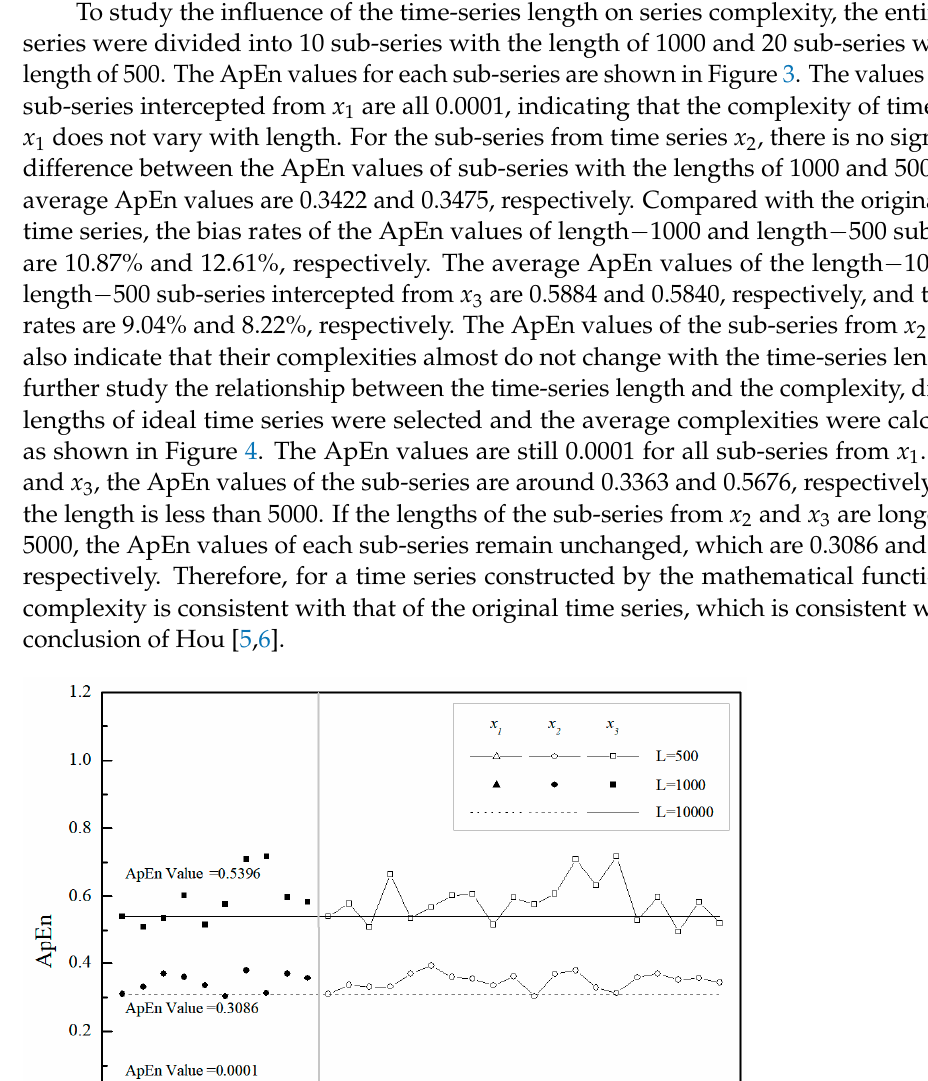
Figure 4. The ApEn values of sub ‐ series with different lengths. By mixing the ideal sequences, more complex sequences were obtained. In this way, we can study the change in the complexity of these new sequences. The complexities of mixed ideal time series y 1 and y 2 with the ideal time series x 1 , x 2 and x 3 were studied, and the ApEn values of 20 sub ‐ series with the length of 1000 are shown in Figure 5, with dif ‐ ferent colors representing different sub ‐ series. The box plots of ApEn values are shown on the right side. The horizontal ordinate represents the mixing ‐ rate parameter α . When α = 1.0, the mixed time series y 1 and y 2 respectively represent the original ideal time series x 2 and x 3 ; when α = 0.0, both y 1 and y 2 represent the ideal time series x 1 . In addition, the ApEn values of sub ‐ series with the length of 1000, which are intercepted from ideal time series x 1 , are marked as red stars. Specifically, the ApEn values of sub ‐ series from y 1 are between 0.2394 and 0.7669, and the ApEn values of sub ‐ series from y 2 are between 0.3949 and 0.7796. By comparing the values of box plots and red stars, it is found that the com ‐ plexity of the mixed time series is remarkably greater than that of the wave function no matter the value of α , and their ApEn values are closer to the chaotic components. It is verified that the complexity of the time series mainly depends on the chaotic component.